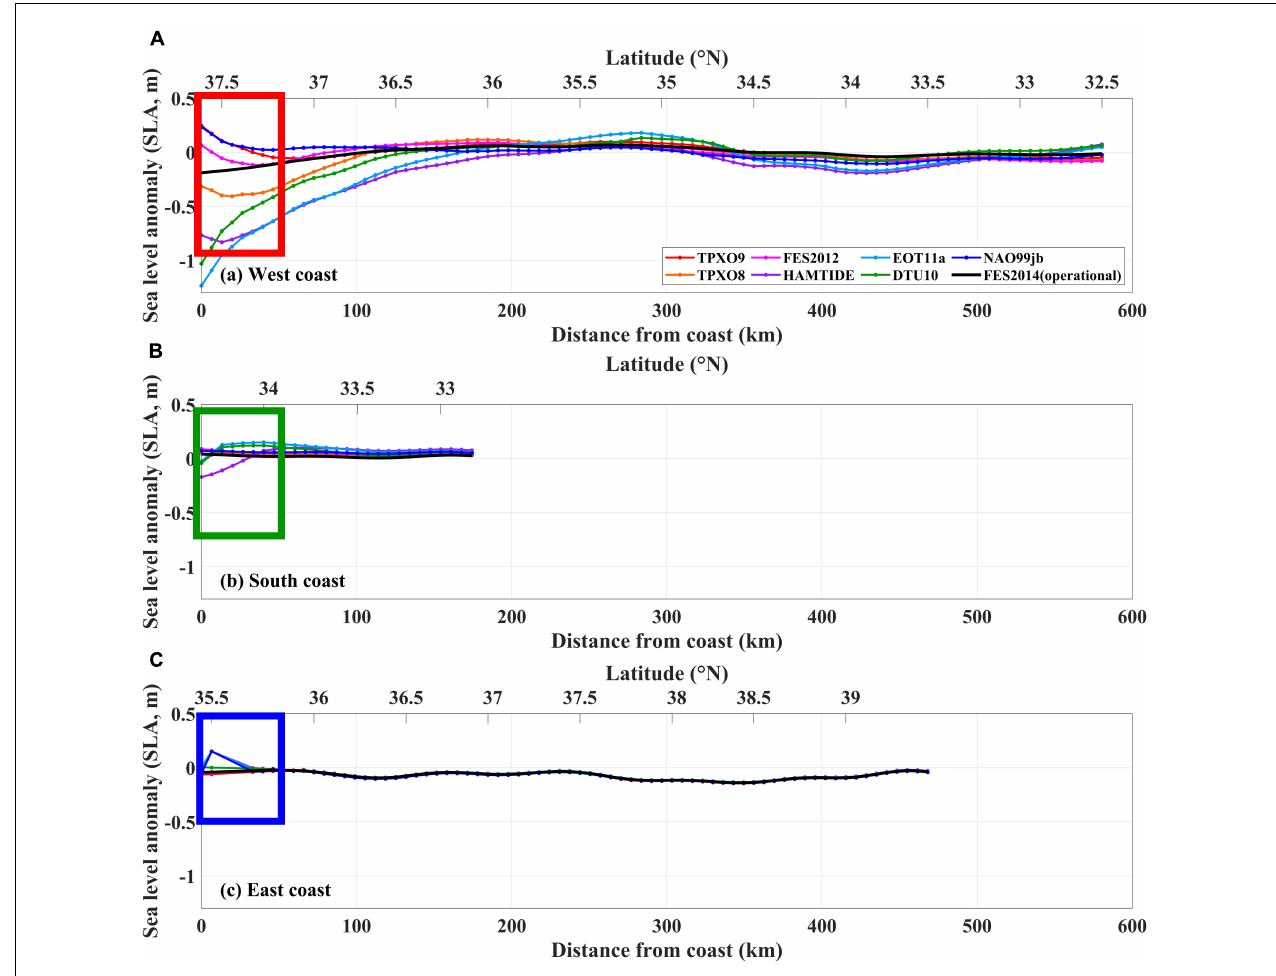
FIGURE 3 | Snapshot of SLA (m) along selected descending tracks as a function of distance (km) off the (A) west (from 02:03 to 02:04 UTC 11 January 2009), (B) south (from 01:52 to 01:53 13 May 2018), and (C) east (from 01:45 to 01:46 17 February 2006) coasts of KP (marked with thick colored lines in Figure 1 ). Data were corrected by eight ocean tide models (colored lines; see legend in upper-right corner). Areas near the coast ( < 50 km) are highlighted by colored boxes (as in Figure 1